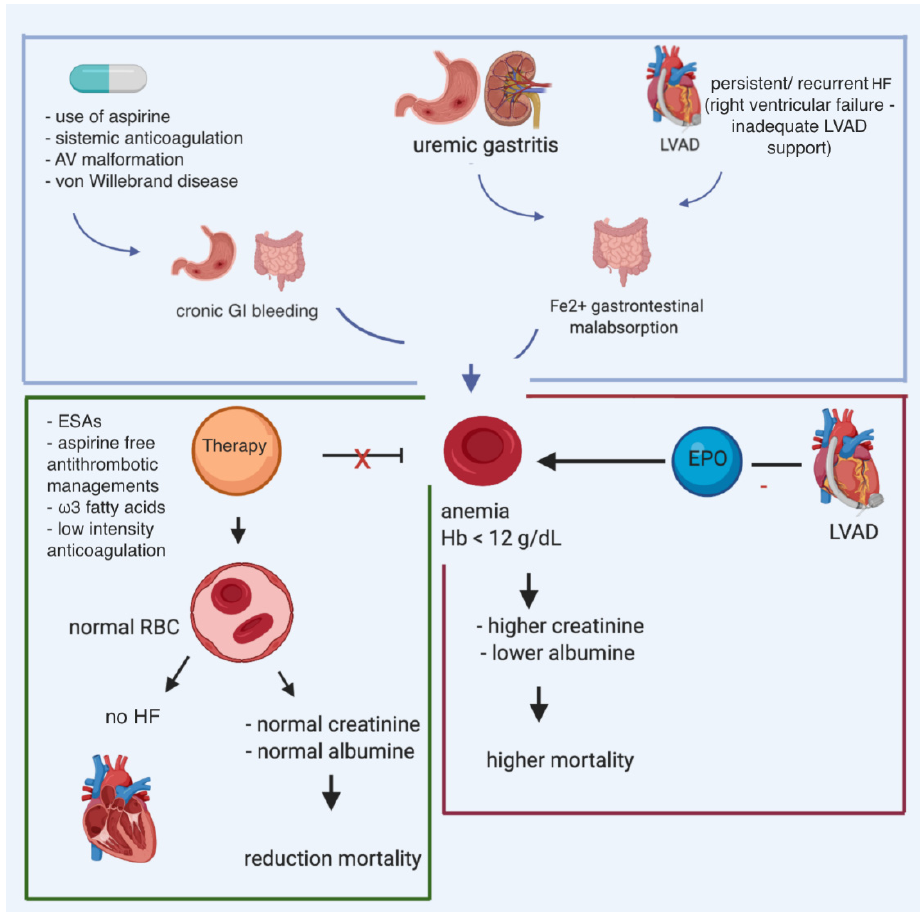
Figure 3. Multiple causes of anemia in patients affected with heart failure and carrying LVAD, and potential impact of iron supplementation and erythropoietin.